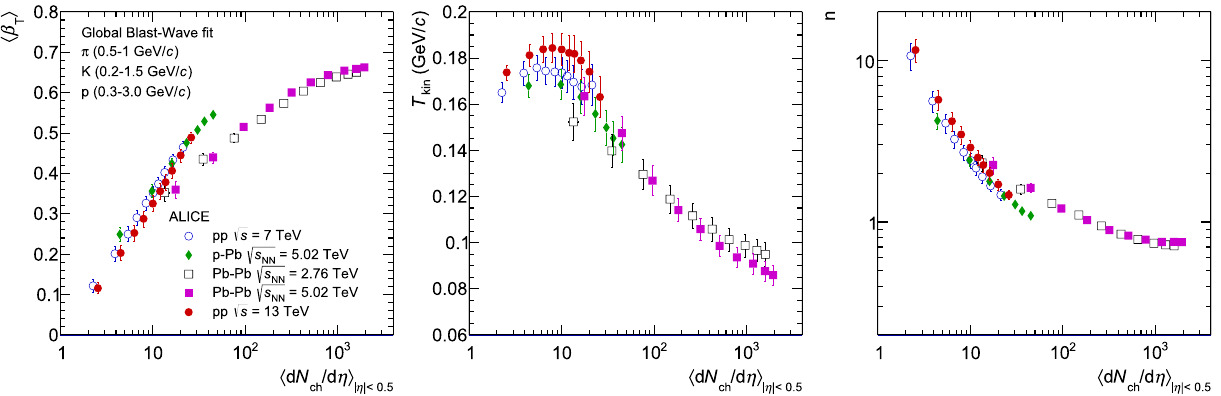
Fig. 4 Evolution of (cid:4) β T (cid:5) , T kin , and n with (cid:4) d N ch / d η (cid:5) . (cid:4) β T (cid:5) , T kin and n are extracted from Blast-Wave fits to π , K, and p p T spectra measured in